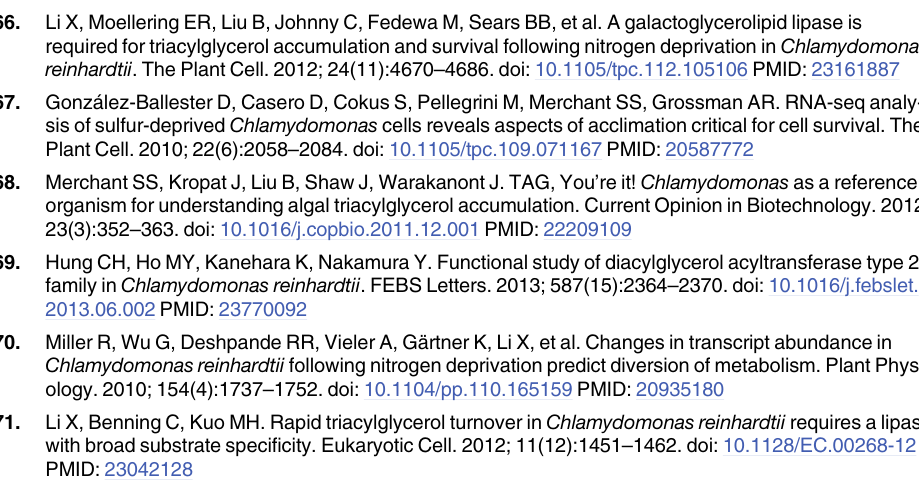
PLOS ONE | DOI:10.1371/journal.pone.0147527 February 3,